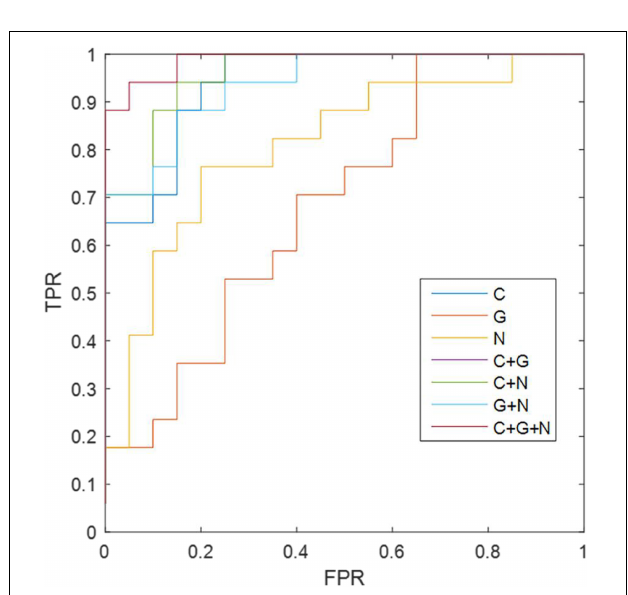
FIGURE 3 | The ROC results of different methods. C, morphological connectivity; G, global metric; N, nodal metric; TPR, true positive rate; FPR, false positive rate.